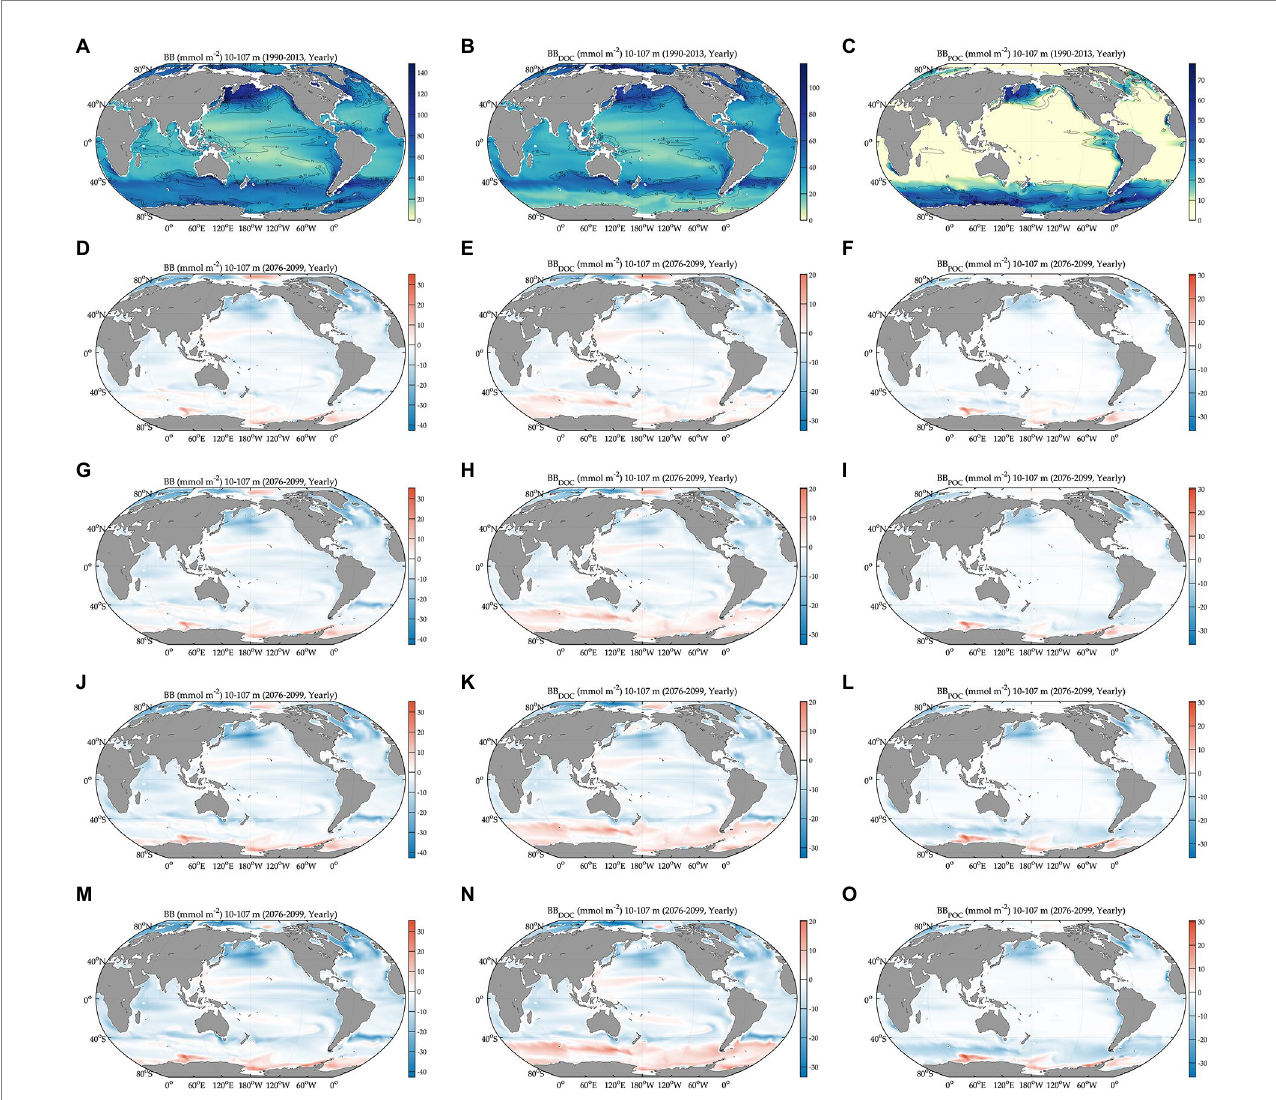
FIGURE 1 Global projections of bacterial carbon biomass during the baseline period (1990–2013) and their anomalies under different climate change scenarios relative to the baseline period (2076–2099). BB: bacterial carbon biomass, BB DOC : biomass of free-living bacteria, and BB POC : biomass of particle-attached bacteria. Bacterial carbon biomass during the baseline period (A) and its change relative to (A) under different SSPs (D,G,J,M) . Carbon biomass of free-living bacteria during the baseline period (B) and its change relative to (B) under different SSPs (E,H,K,N) . Carbon biomass of particle-attached bacteria during the baseline period (C) and its change relative to (C) under different SSPs (F,I,L,O) . All variables are depth-integrated in the upper 100 m. Solid-line contours as standard deviation from averaging over 1990–2013. Anomalies are 2076–2099 average values relative to 1990–2013 average values. SSP1–2.6: